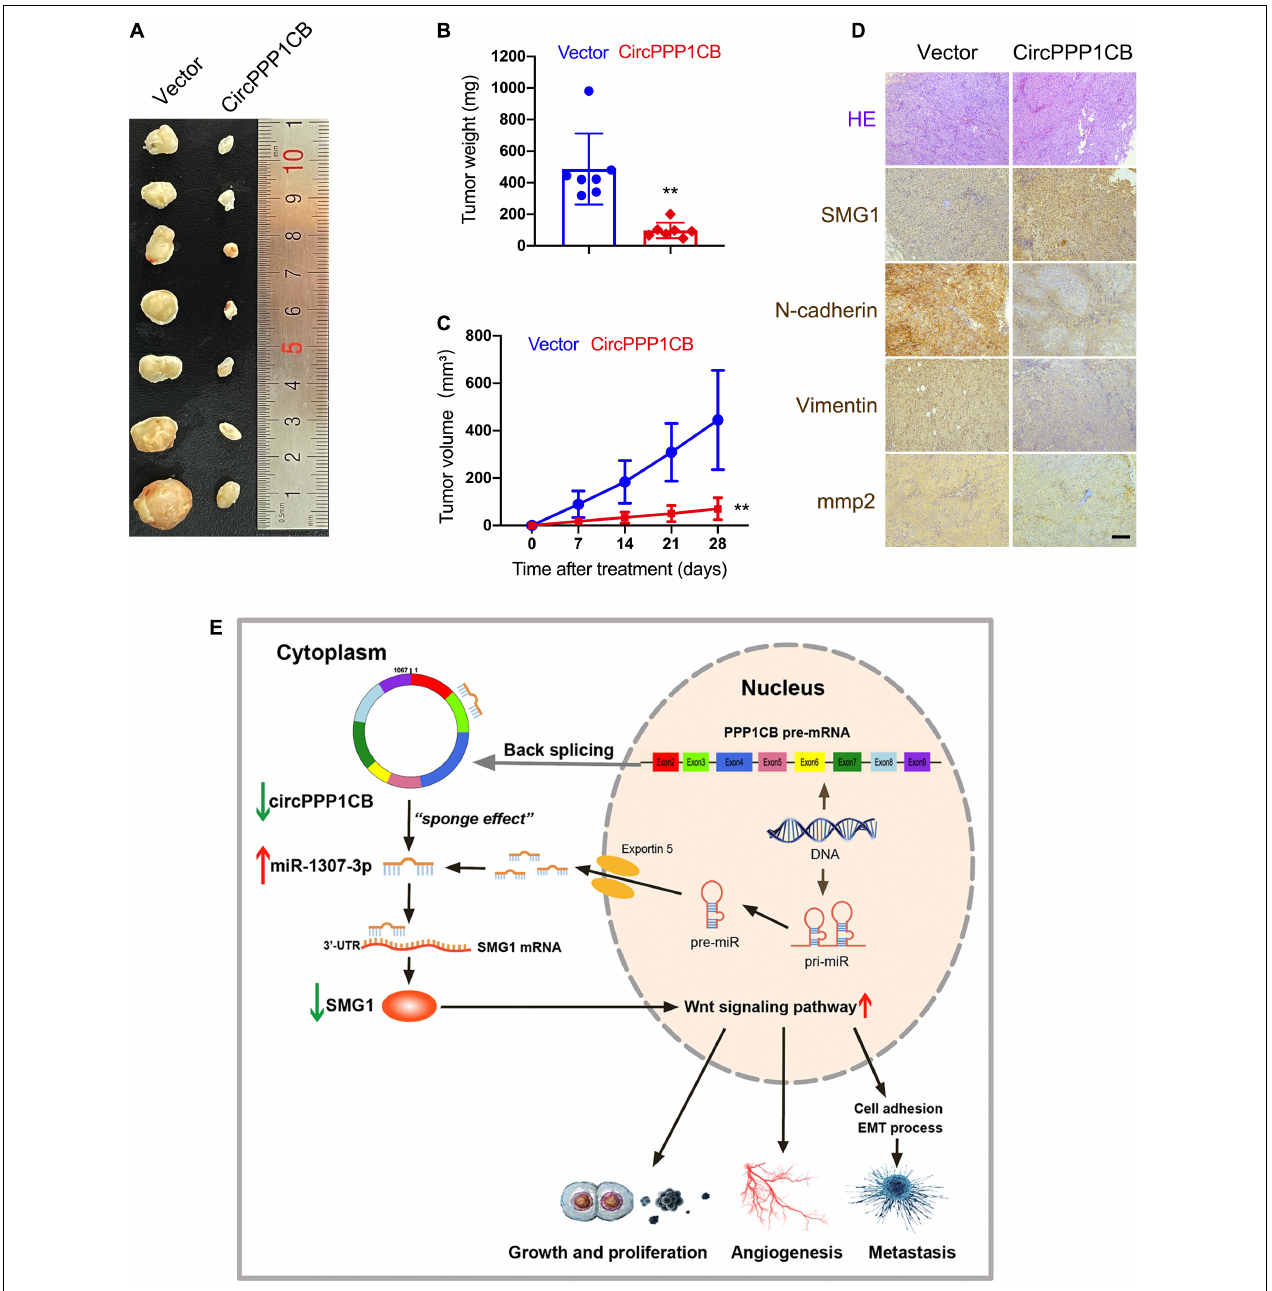
FIGURE 7 | CircPPP1CB suppresses tumor growth in vivo . (A) An equal number of control or circPPP1CB-overexpressing T24 cells were injected subcutaneously to establish xenograft tumors. After 28 days, tumors were harvested ( n = 7 each group). (B,C) Tumor weight was determined when mice were sacrificed, and tumor volumes were measured and calculated every week. (D) HE staining and immunohistochemistry (IHC) detection of SMG1, MMP2, and EMT markers in tumors. (E) A graphical abstract illustrating that circPPP1CB inhibits bladder cancer tumorigenesis by interacting with miR-1307-3p and regulating SMG1 expression. * p < 0.05, ** p < 0.01 vs. control